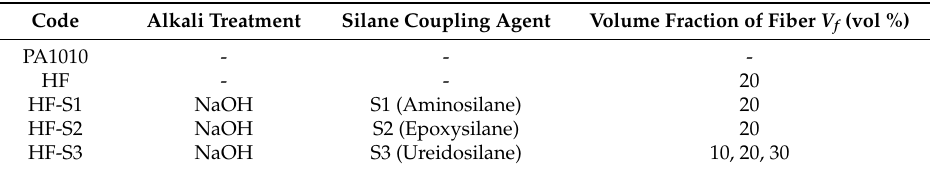
Table 2. Code, alkali treatment, silane coupling agent and volume fraction of fiber of HF/PA1010 biomass composites used in this